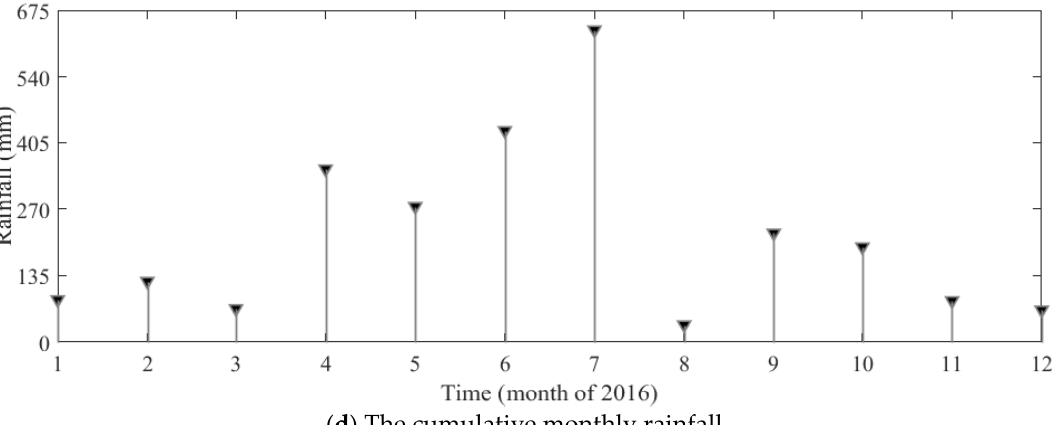
( d ) The cumulative monthly rainfall. Figure 2. Variation of the water level ( a ), SSC ( b ), runoff ( c ) and rainfall ( d ) at Datong hydrological station.